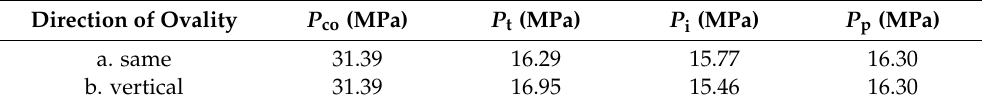
Table 4. Effect of ovality direction.